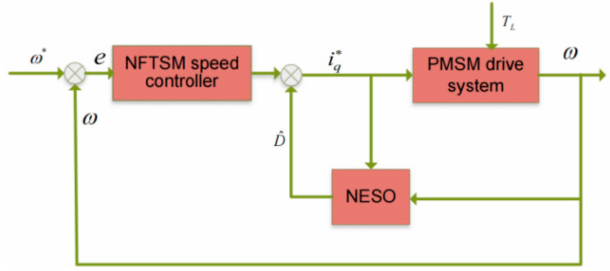
Figure 1. Schematic diagram of PMSM control